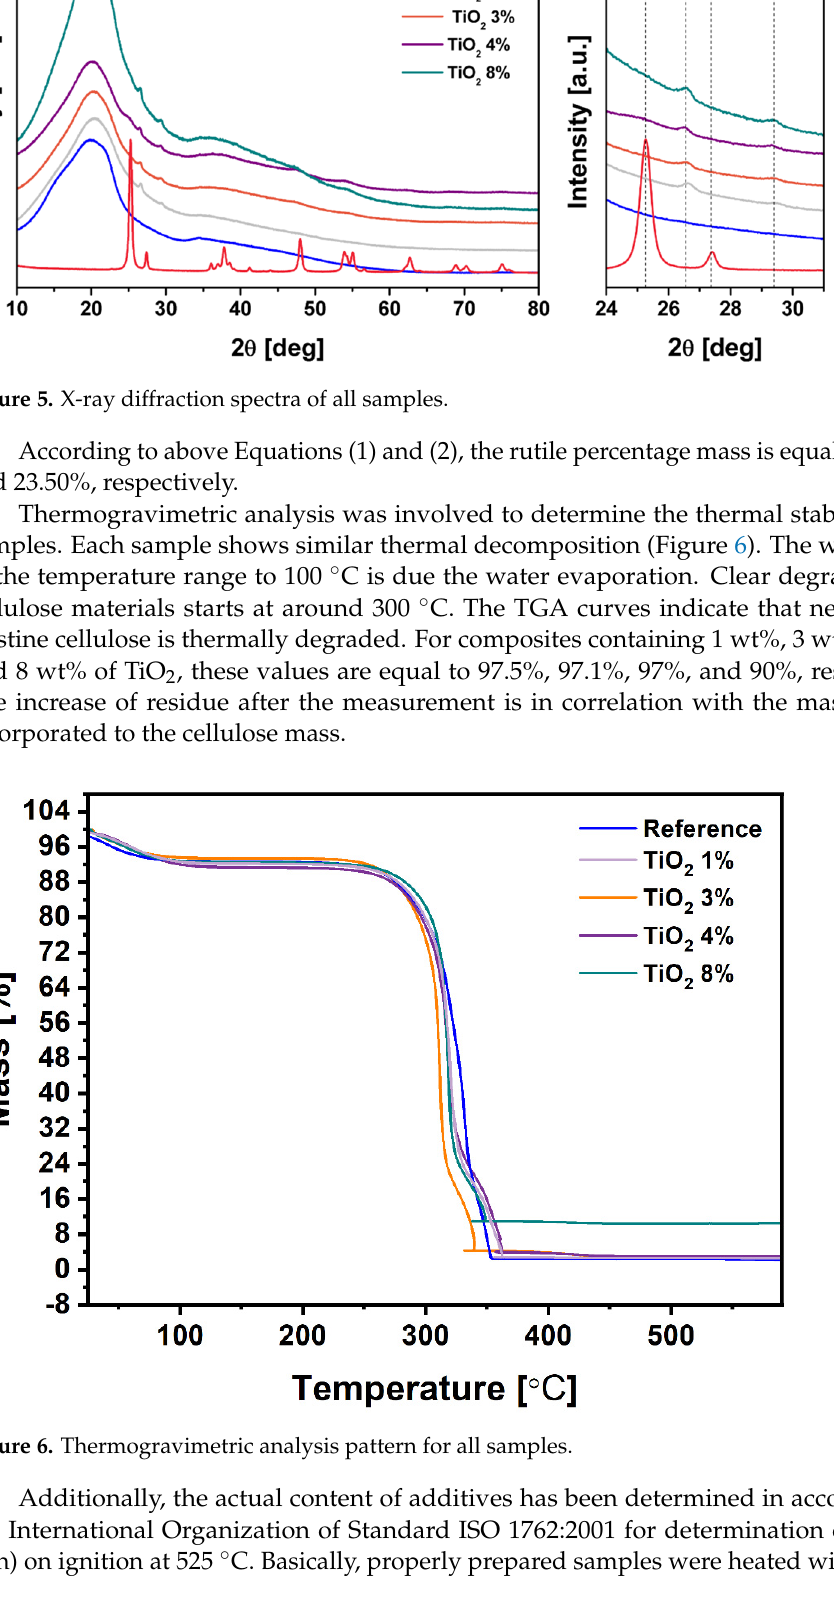
Figure 6. Thermogravimetric analysis pattern for all